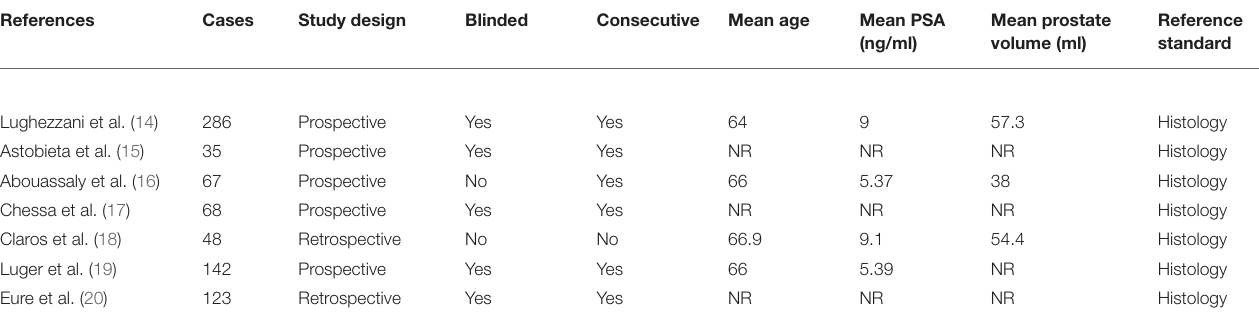
TABLE 1 | Baseline characteristics of included